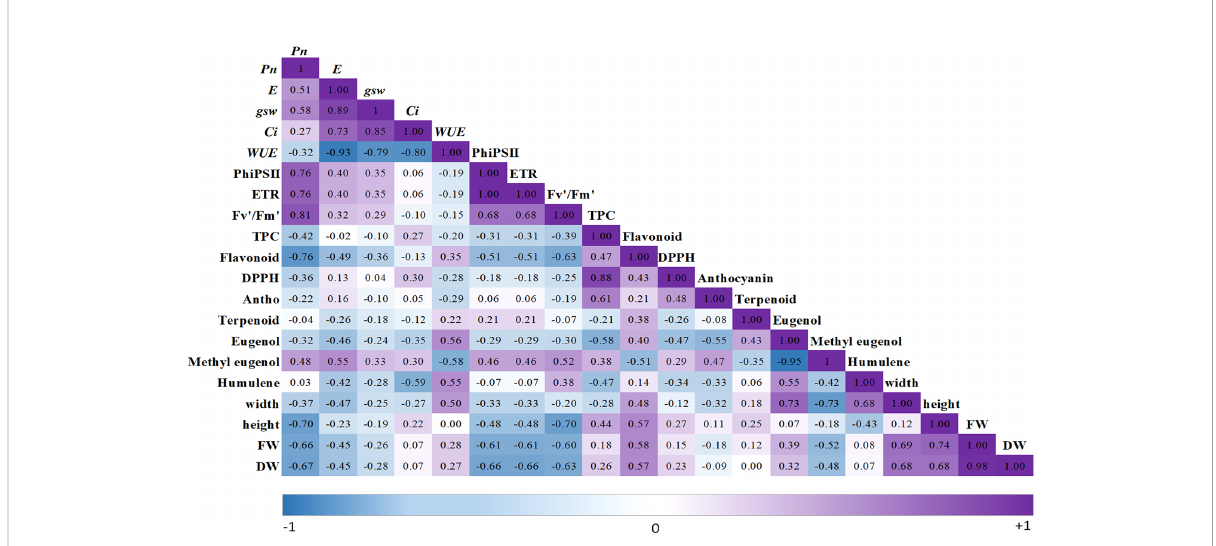
FIGURE 9 A correlational plot from 20 parameters recorded for 12 holy basils. Pn , net photosynthetic rate; E , transpiration rate; gsw, stomatal conductance; Ci , internal CO2 concentration; WUE , and water use ef fi ciency; PhiPSII, photochemical ef fi ciency of PSII. F v ′ /F m ′ , PSII maximum ef fi ciency; ETR, electron transport rate; TPC, total phenolic compounds, fl avonoid content; DPPH, radical scavenging, anthocyanin content, total terpenoids content, eugenol content, methyl eugenol content; Humulene, a -humulene content; width, plant width; height, plant height; FW, fresh weight and DW, dry